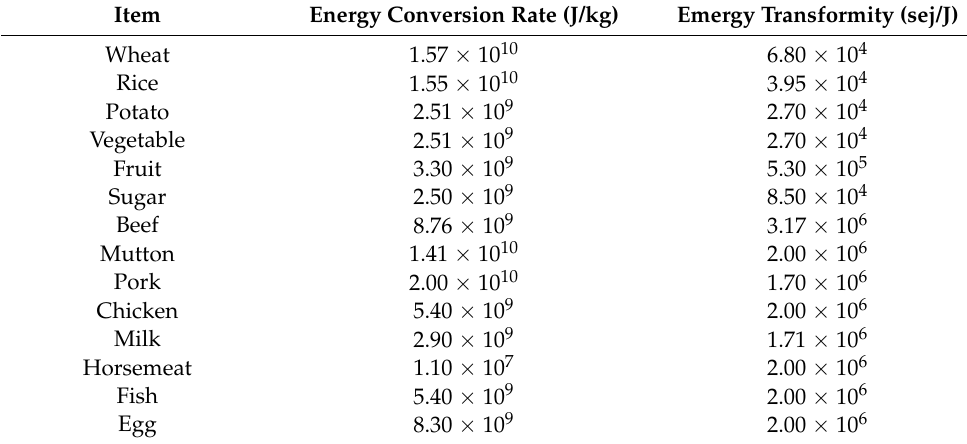
Table 1. Energy conversion rate and emergy transformity for each food item [49]. Item Energy Conversion Rate